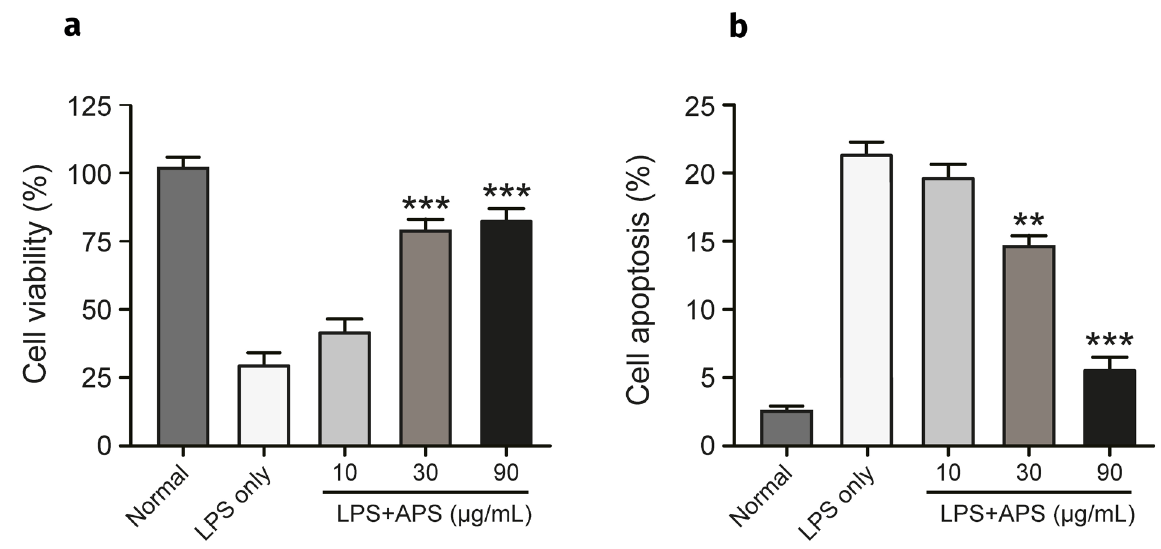
Figure 1. Effects of APS incubation on (a) cellular viability and (b) cellular apoptosis of H9C2 cell. * = p < 0.05, ** = p < 0.02, *** = p < 0.001 vs. LPS treated only cell group. Values represent mean ± SD of 5 independent